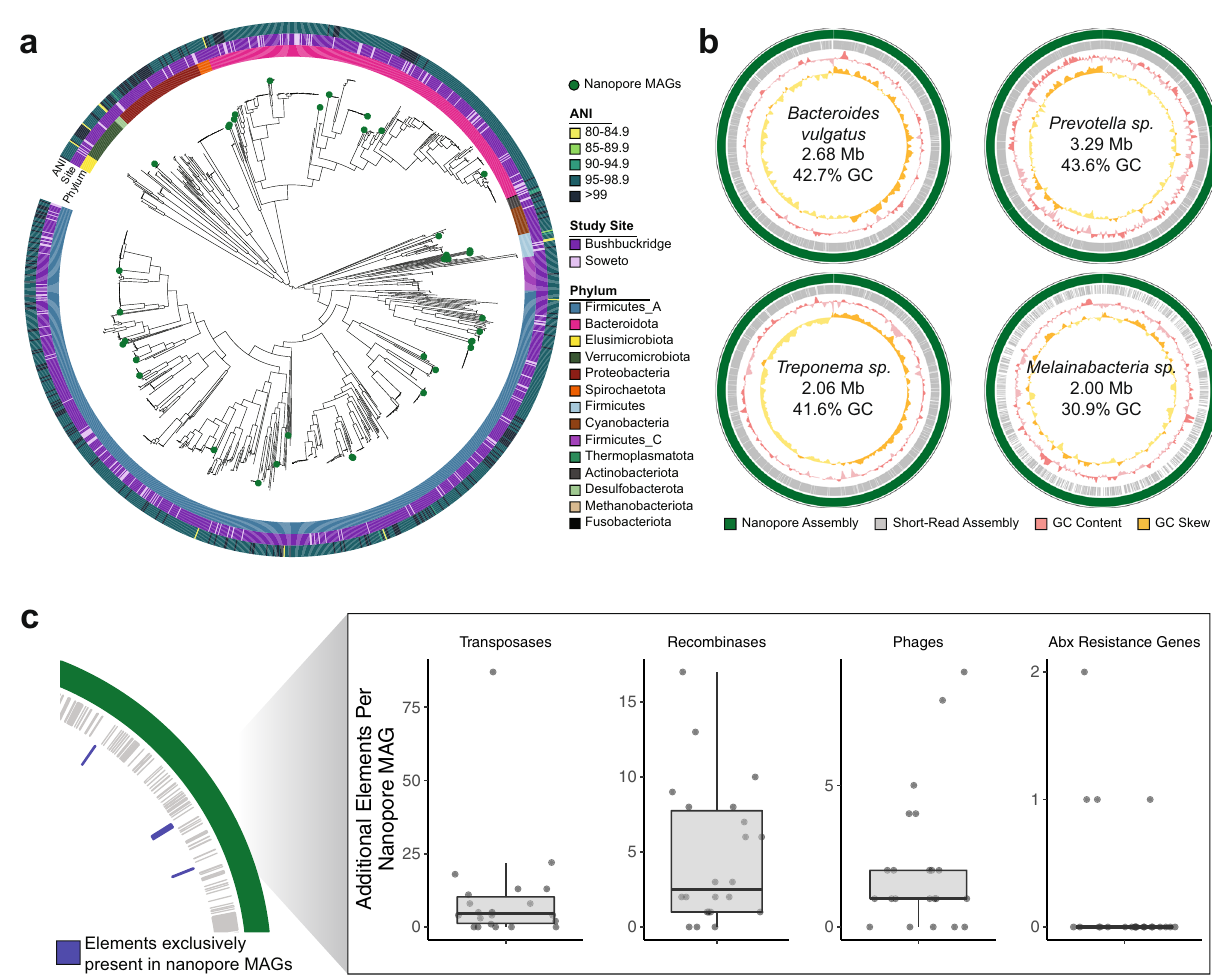
Fig. 5 Complete and contiguous genomes of South African microbiota. a Phylogenetic tree of de-replicated short-read MAGs and medium- and high- quality nanopore MAGs (green circles). Innermost ring indicates GTDB phylum, middle ring indicates study site associated with each MAG, and outer ring indicates the highest average nucleotide identity between each MAG and genomes from the UHGG. b A selection of MAGs assembled from long-read sequencing (green) of three South African samples compared contigs assembled from corresponding short-read data (gray). Third track (pink) indicates sliding genomic GC content, and fourth track (yellow) indicates sliding genomic GC skew. Breaks in circles represent different contigs. Genomic information within plots refer to assembly statistics of nanopore MAGs. c Number of additional genomic elements present in medium- and high-quality nanopore MAGs ( n = 22) that are absent in corresponding short-read MAGs for the same organism, as diagrammed in the left-hand panel. Box plot lower and upper hinges correspond to the fi rst and third quartiles, upper and lower box plot whiskers represent the highest and lowest values within 1.5 times the interquartile range, and the horizontal line represents the median. ANI average nucleotide identity, Mb megabase, Abx antibiotics, MAG metagenome- assembled